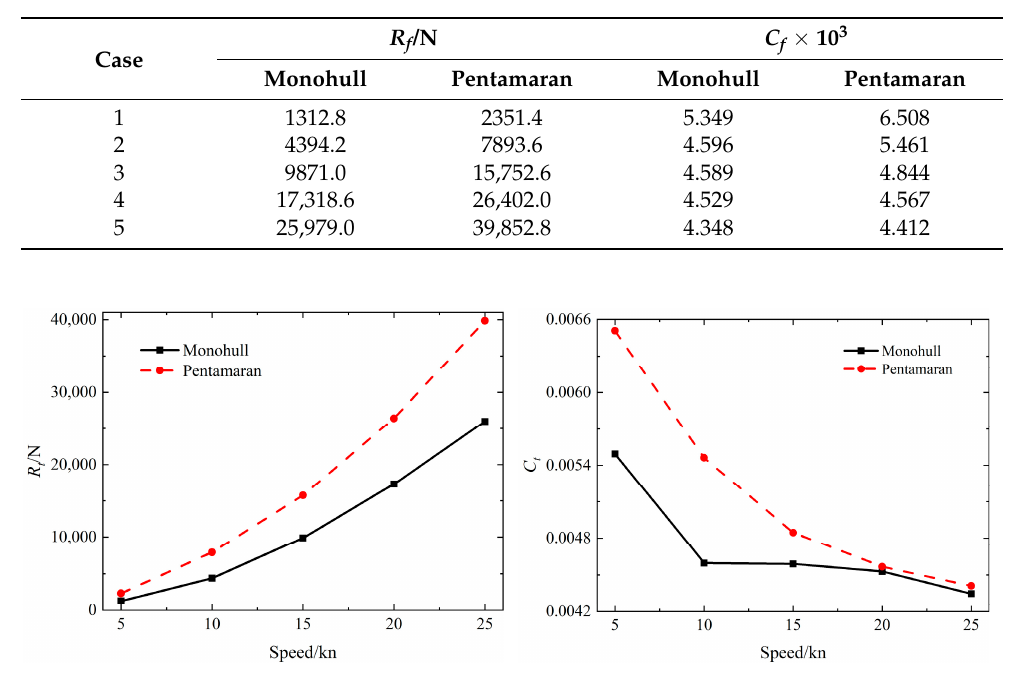
Figure 16. R t and C t curves.